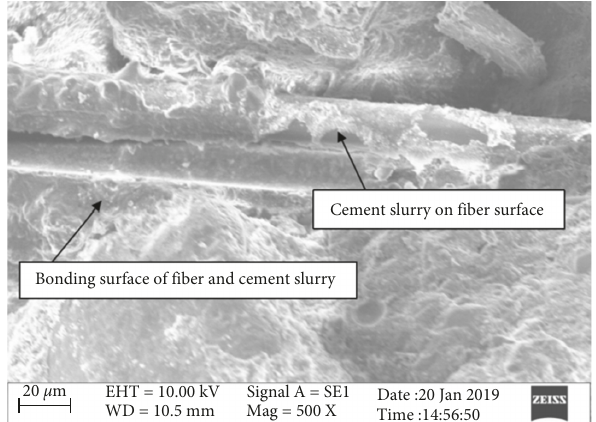
Figure 23: Bond interface between basalt fiber and cement slurry.